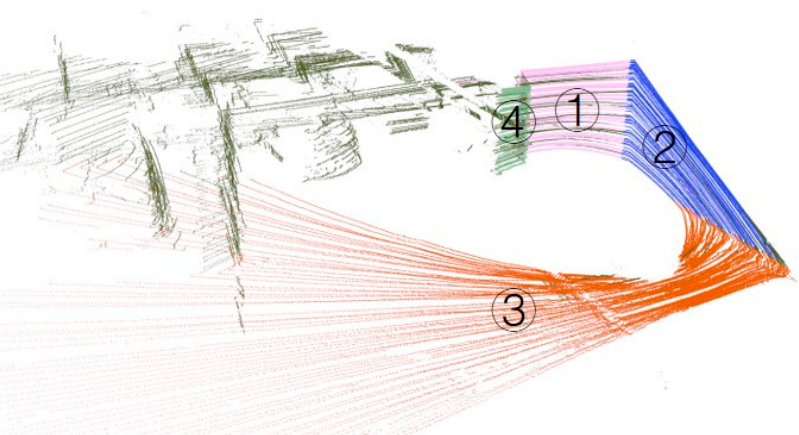
Figure 8. The point cloud of the experimental scene.